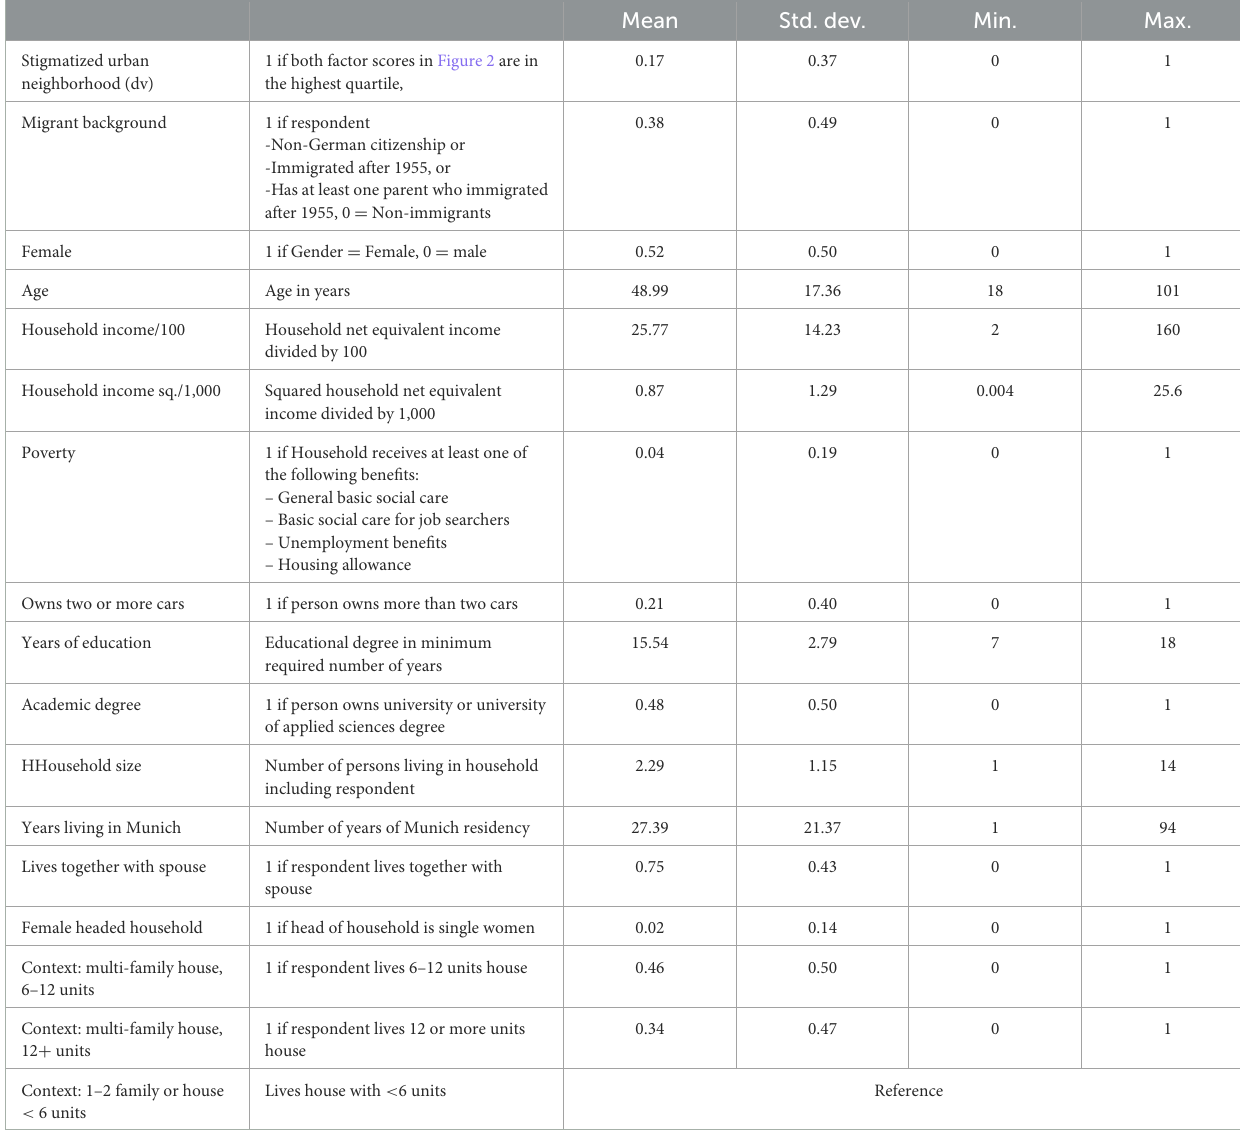
TABLE 2 Definition of variables, N =